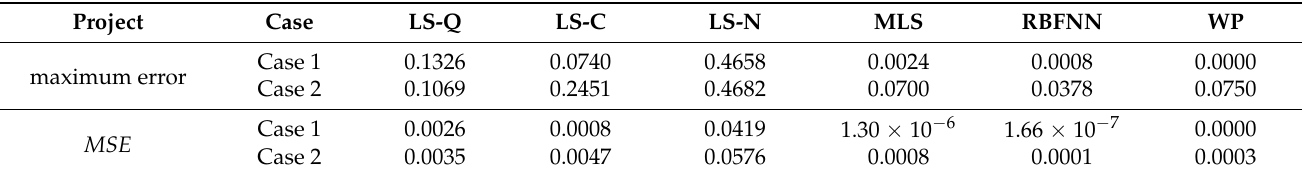
Table 7. Maximum error and MSE for